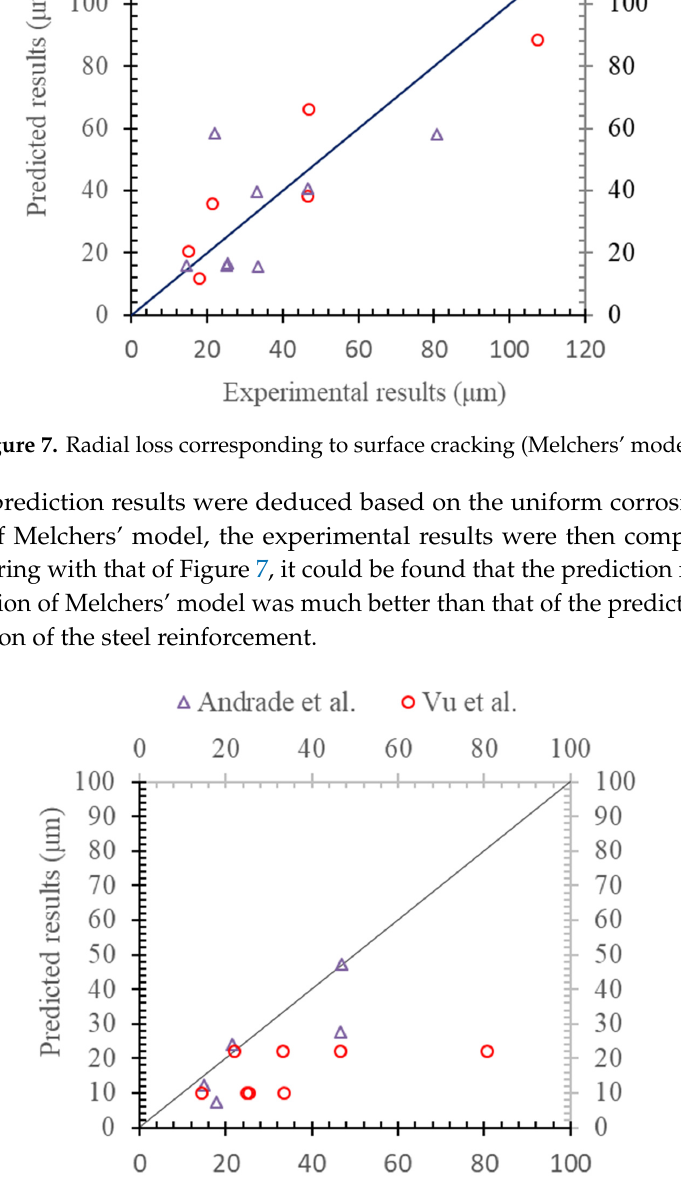
0.20.3 Figure 9. Relationship of the pitting corrosion and the crack width. It could be found that the results predicted by the proposed prediction model matched well with Andrade et al.’s experimental results [35]. When the width of the corrosion-induced cracks was 0 0.1